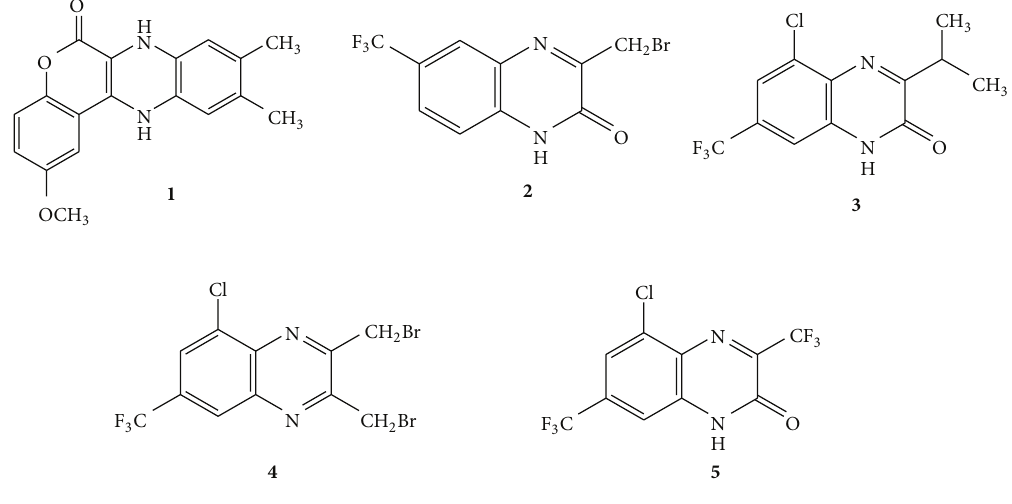
Figure 1: Chemical structures of compounds tested.